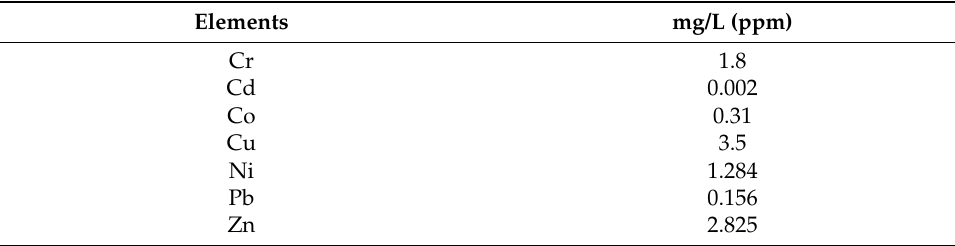
Table 2. Concentration of heavy metals in ISA as found by